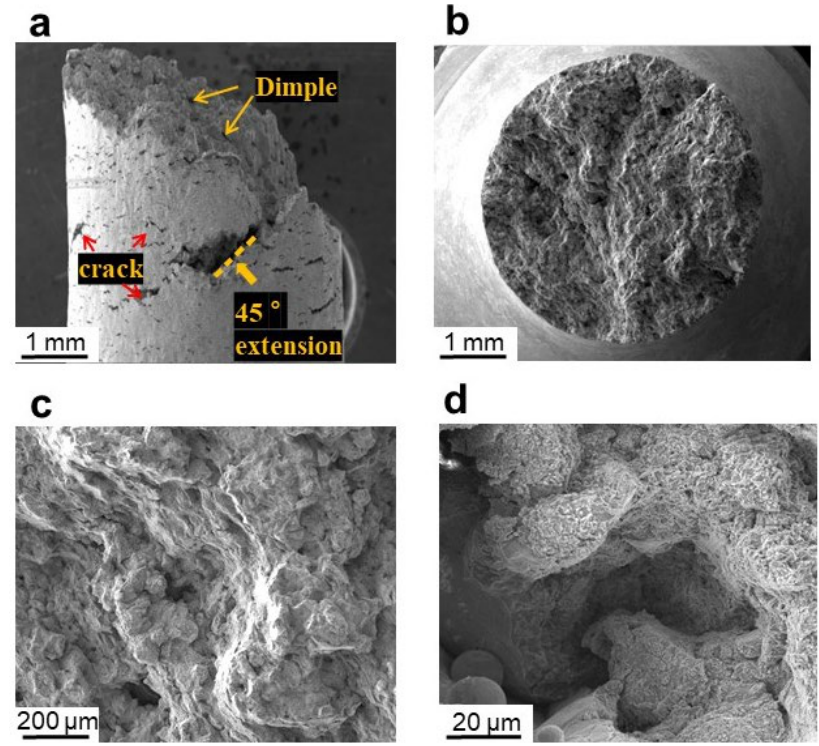
Figure 8. Fracture surface characterization of tensile failed 1175-FC samples by using SEM: ( a ) the side surface of the fracture; ( b ) the front view of the fracture sample; ( c , d ) the morphology of fracture surface under different magnifications.